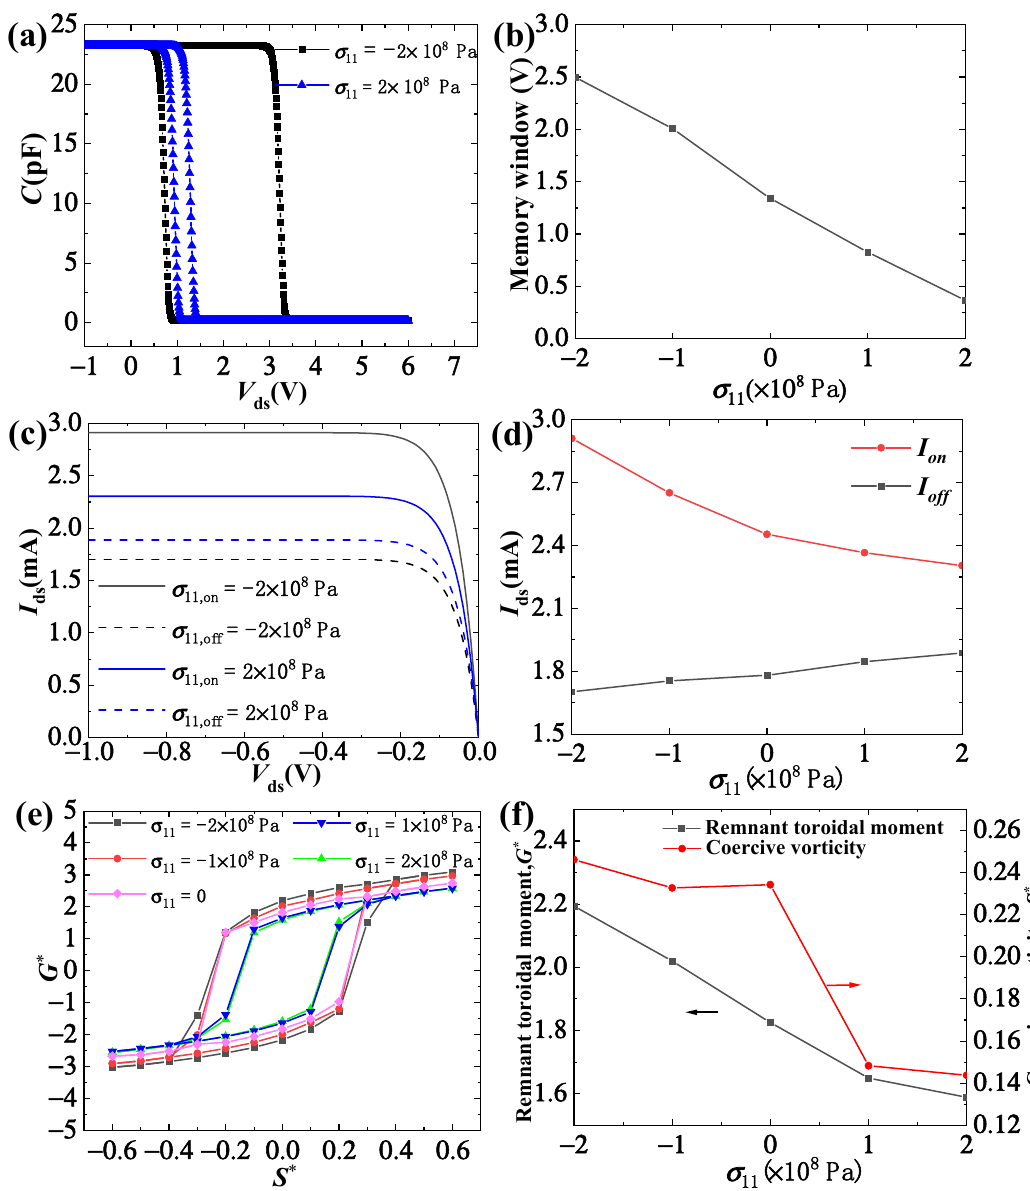
Figure 3. Effect of stress on ferroelectric topology domain transistors of ( a ) C - V ds characteristics of Pt/PTO (20 nm)/Si/SiO 2 structures. ( b ) Memory window. ( c ) I ds - V ds characteristics of Pt/PTO (20 nm)/Si/SiO 2 structures. ( d ) Open-state current and closed-state current. ( e ) G *- S *. ( f ) Coercive vorticity and remnant toroidal moment. The superscript * indicates the corresponding dimensionless posterior parameter.